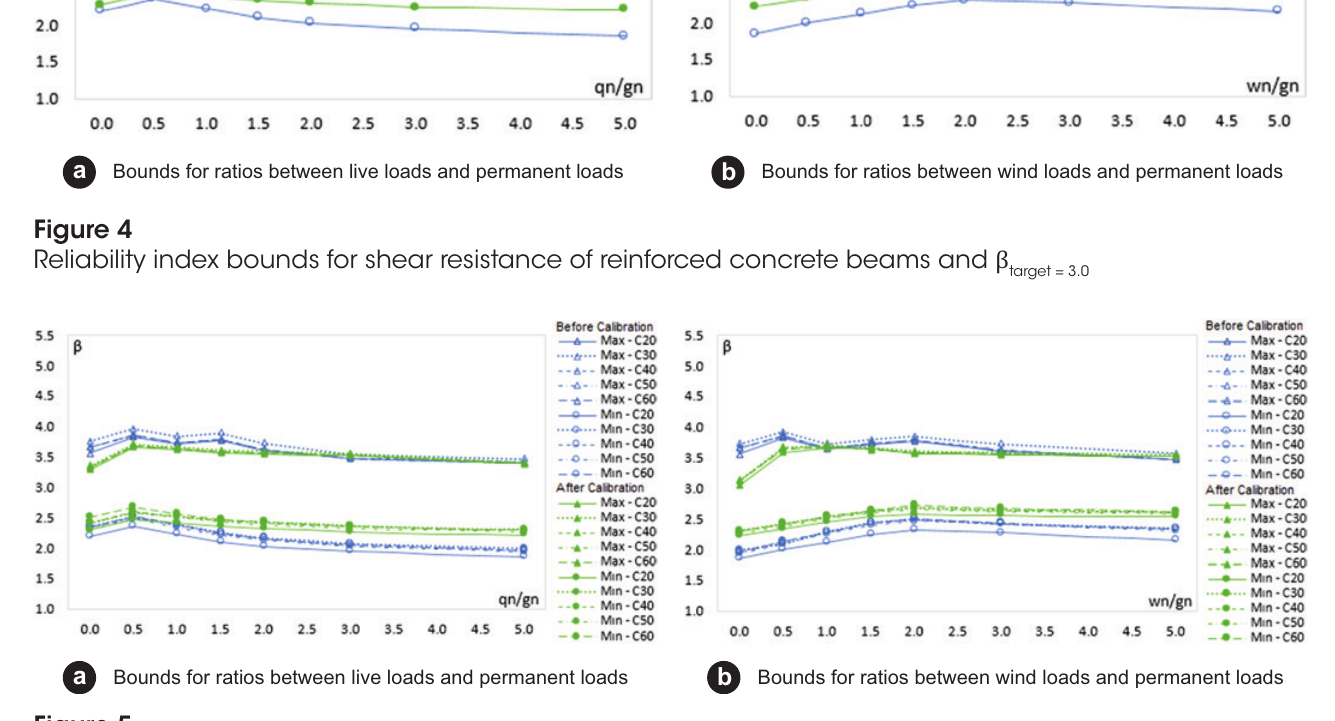
Reliability index bounds for shear resistance of reinforced concrete beams, all concrete classes and